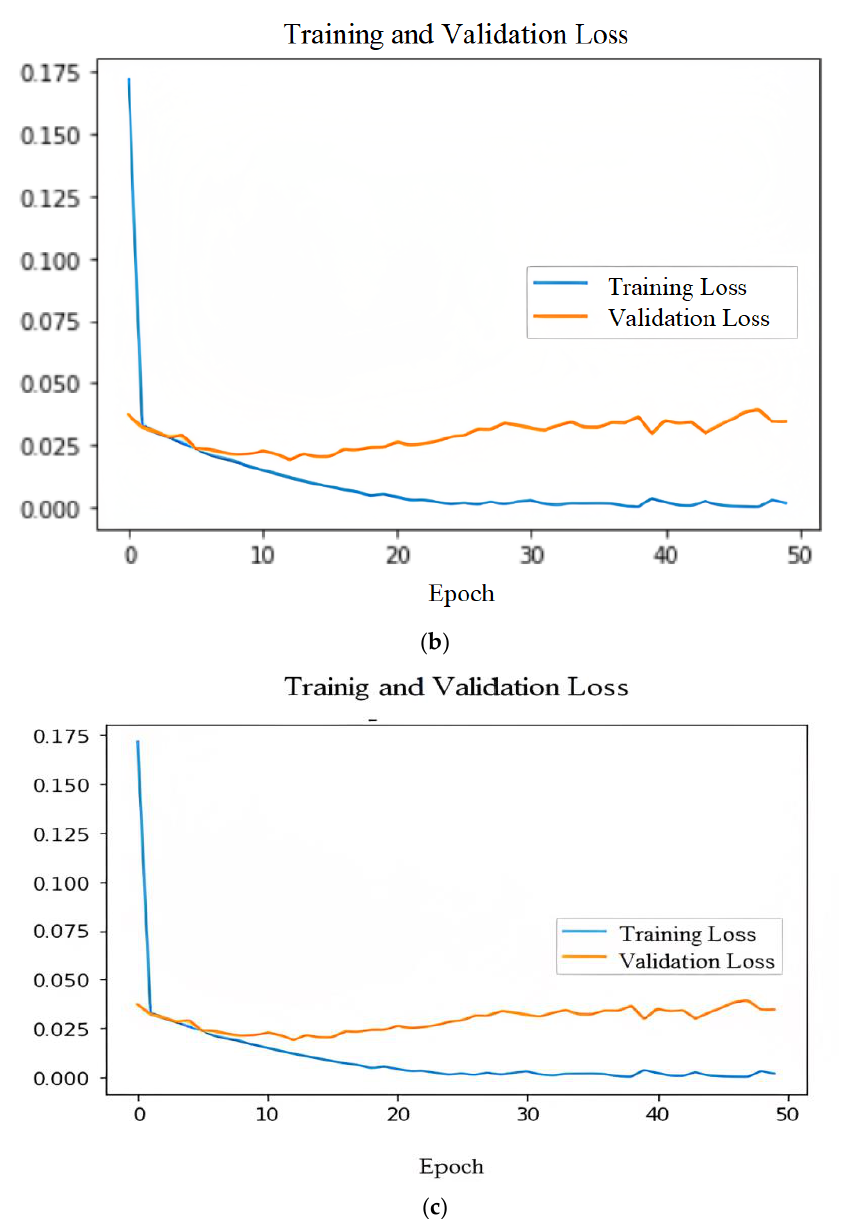
Figure 8. ( a ) Training and validation loss for LSTM model. ( b ) Training and validation loss for Bi-LSTM model. ( c ) Training and validation loss for GRN-based RNN model. Table 2. Comparison table for the accuracy of the proposed LSTM, Bi-LSTM, and GRU models. Model